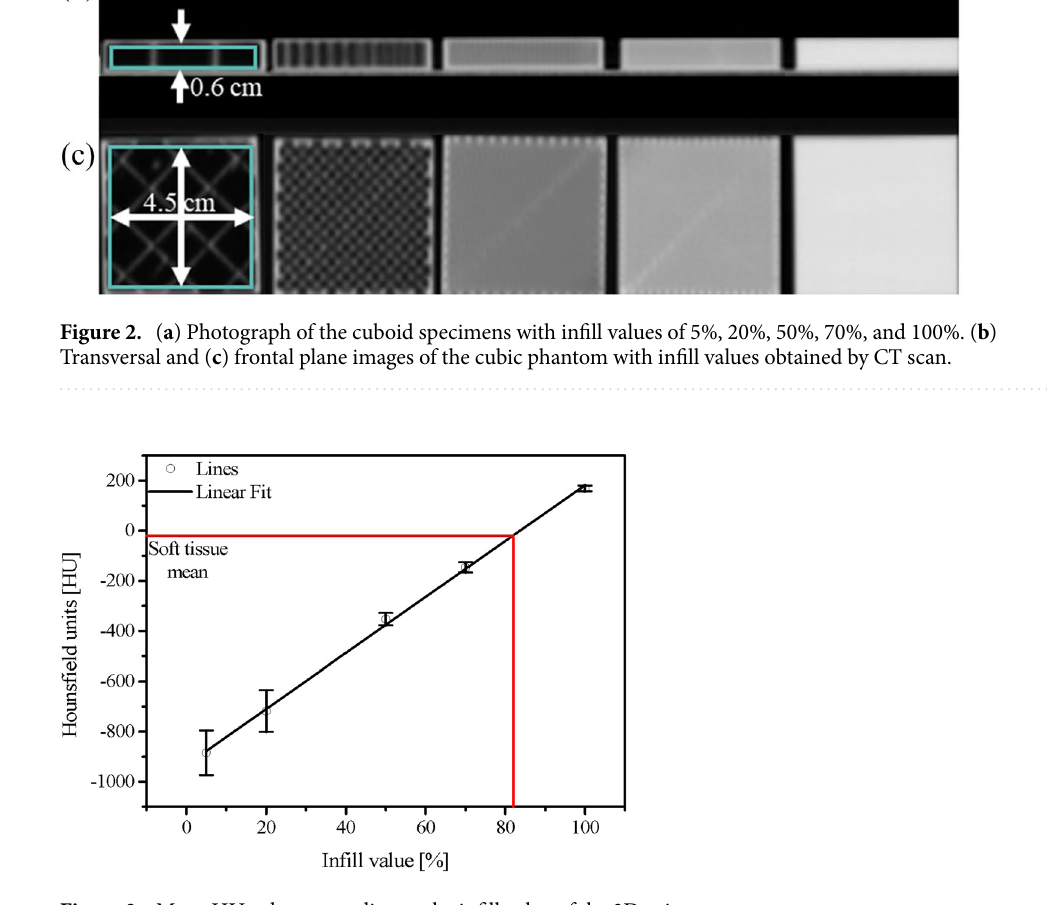
Figure 3. Mean HU values according to the infill value of the 3D